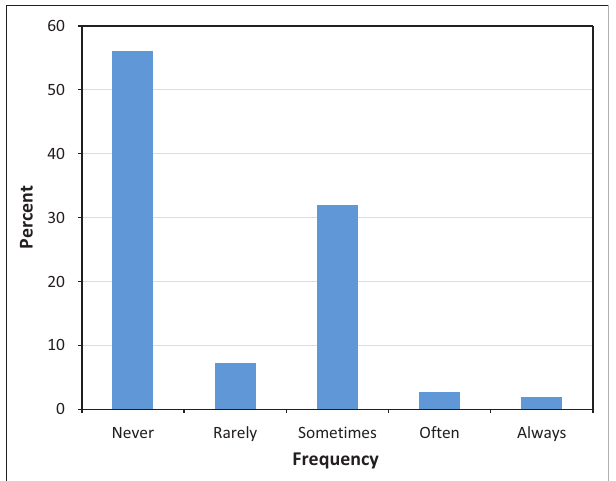
FIGURE 6: Do users travel with other passengers?